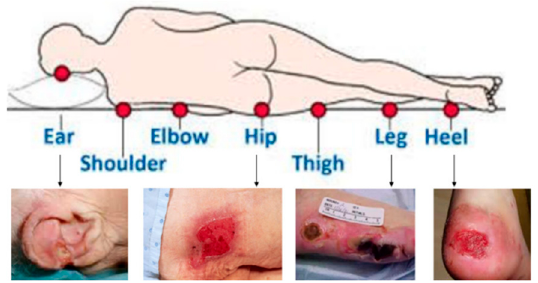
Figure 1. Different locations of HAPI [8].